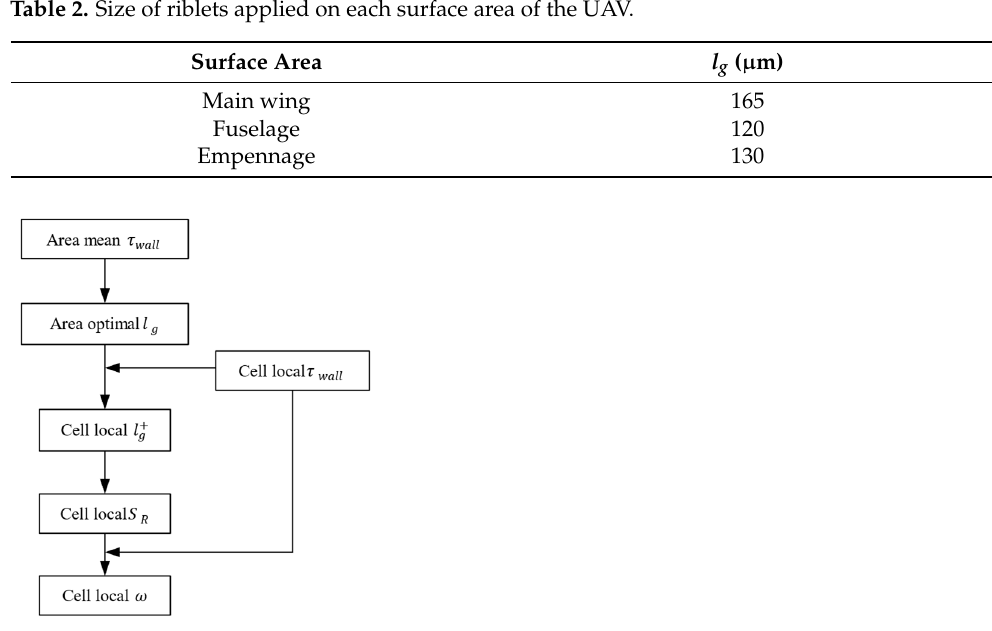
Figure 6. Flowchart of the UDF operation on each surface area. Table 2. Size of riblets applied on each surface area of the UAV.